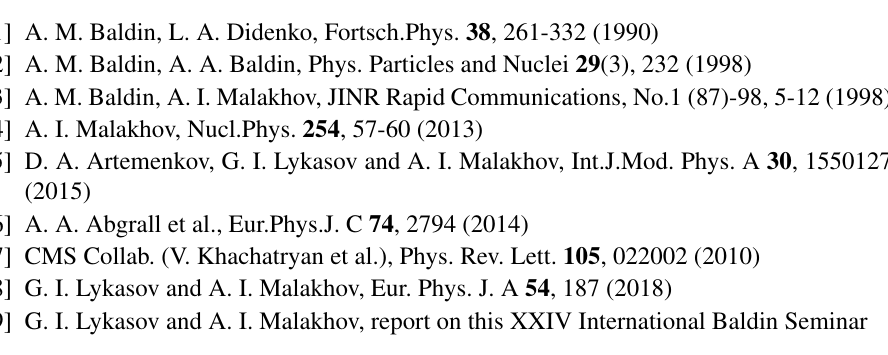
Figure 3. Results of the calculations of the inclusive cross-section of charge hadrons produced in pp collisions at the LHC energies as a function of their transverse momentum p t at are the LHC experimental data